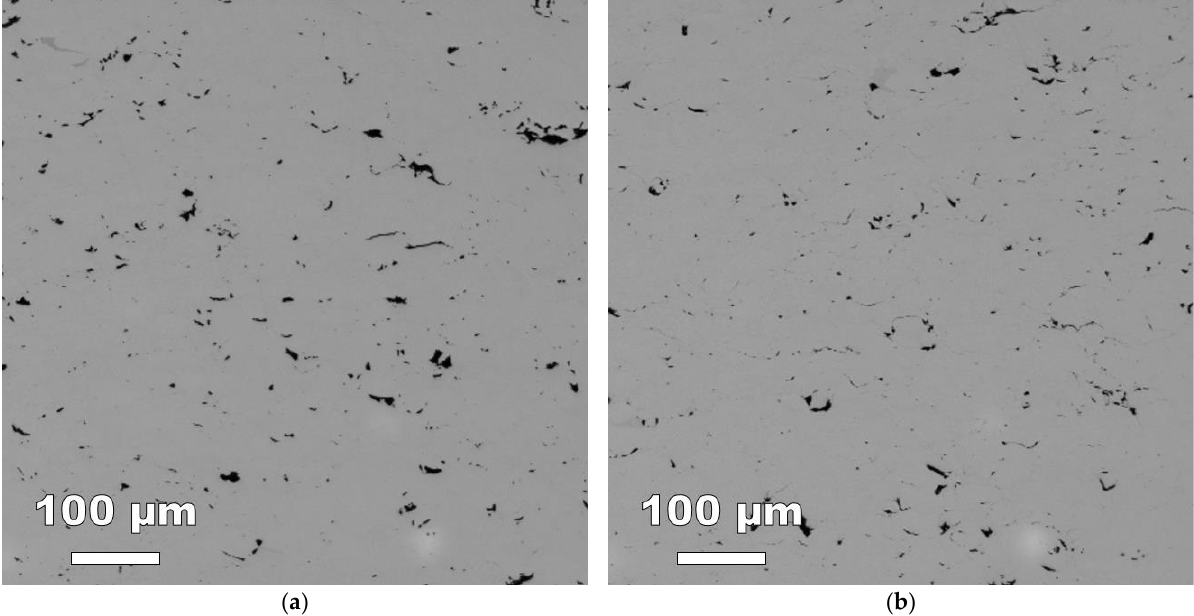
Figure 7. Optical images showing porosity in Inconel 625 coating at ( a ) 3 and ( b ) 8 cm standoff distances.